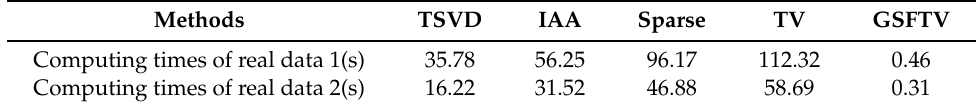
Table 6. Computing time of different